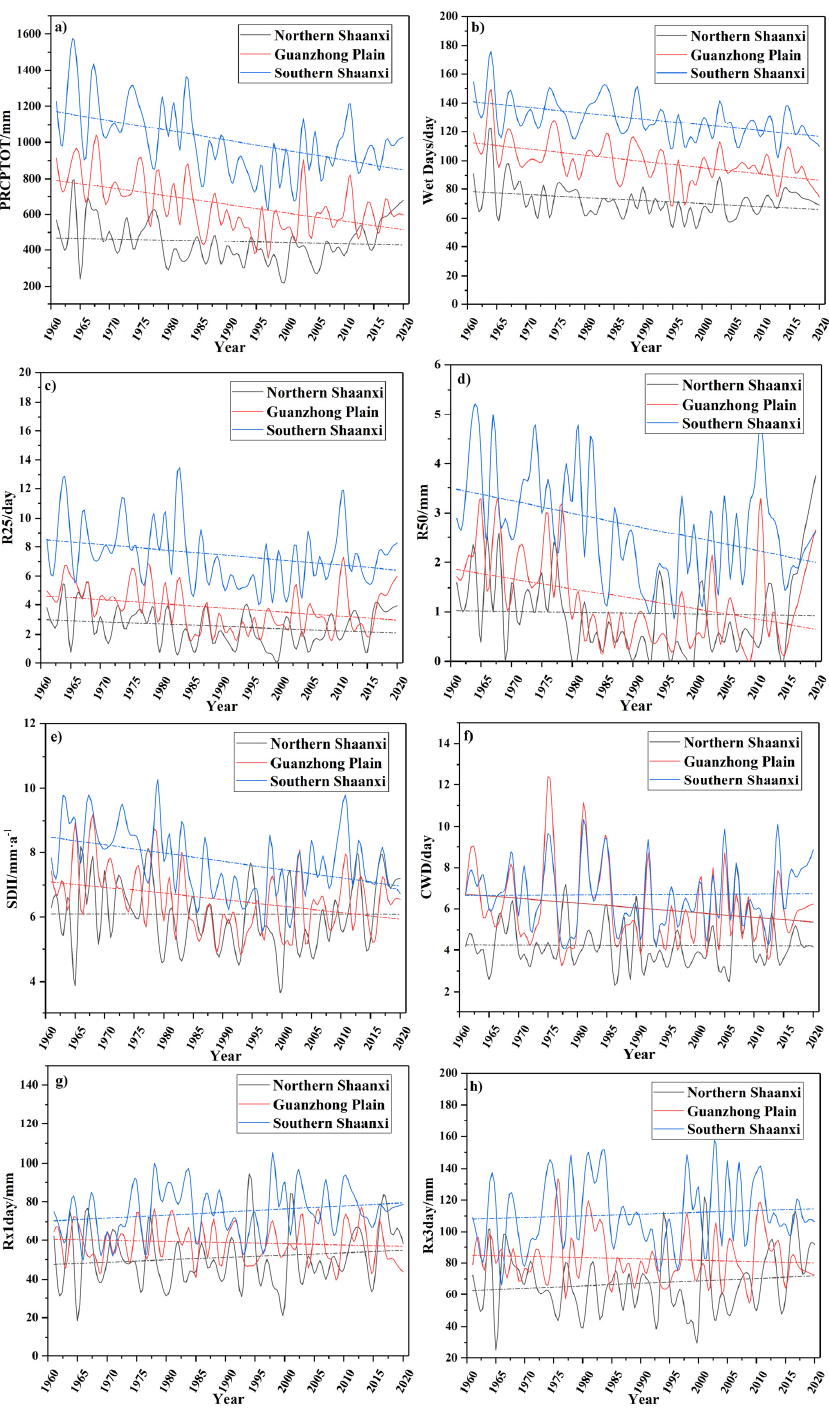
Figure 5. Extreme precipitation index curves for three natural regions from 1961 to 2020: ( a ) PRCPTOT, ( b ) wet days, ( c ) R25, ( d ) R50 and ( e ) SDII, ( f ) CWD, ( g ) Rx1day, ( h ) Rx3day.